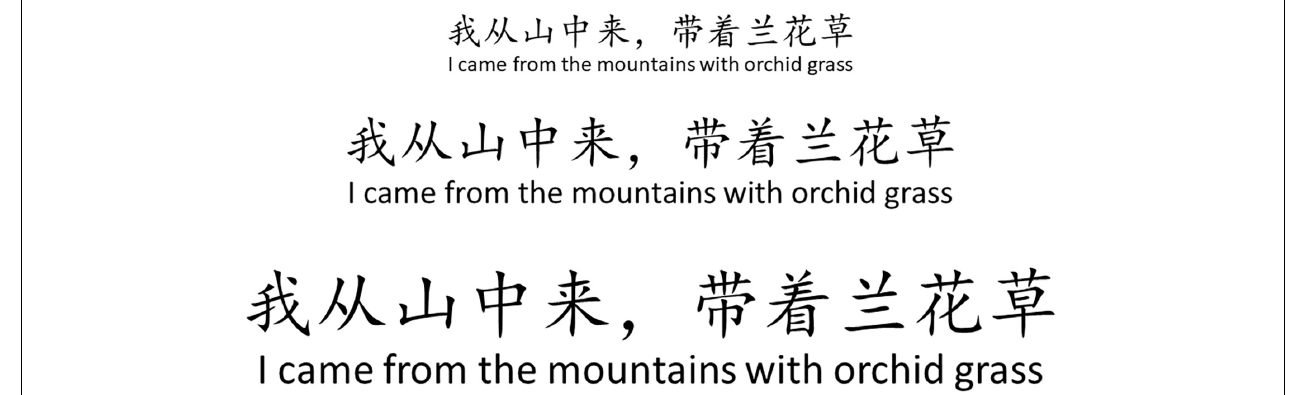
FIGURE 3 | Lyric reading voice volume prompt diagram. The larger the font size is, the larger the volume required. Line 1, font number 3, low volume, about 20–30 dBA; Line 2, small 2 font, moderate volume, about 31–40 dBA; Line 3, font number 2, large volume, about 41–55 dBA.